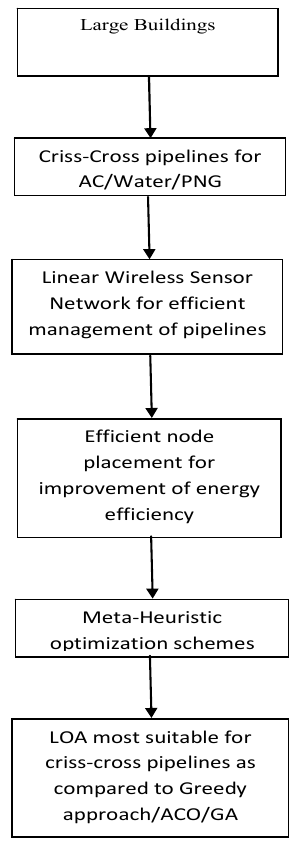
Figure 1. Proposed Problem and Solution.